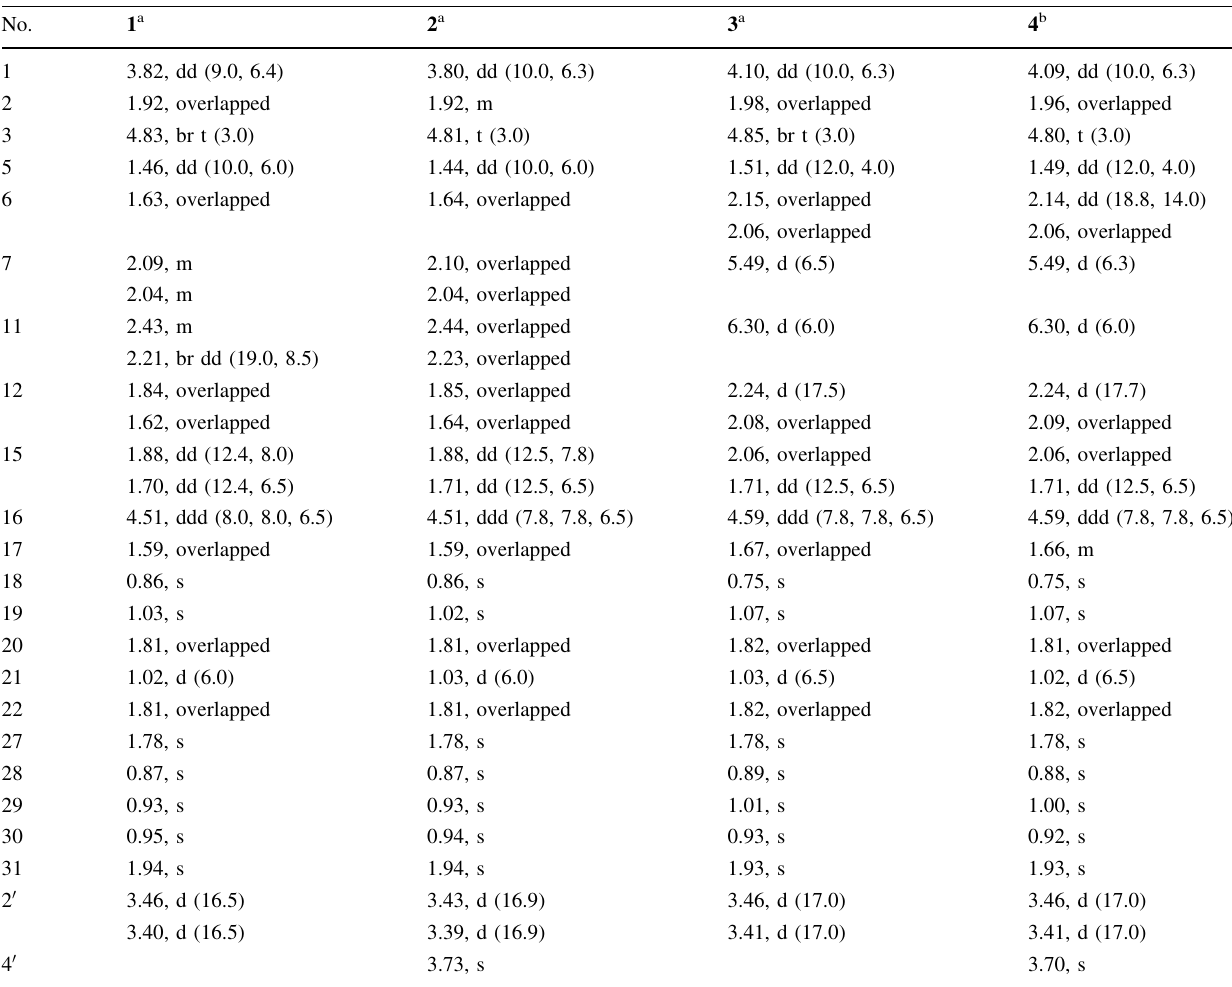
Table 1 1 H NMR spectroscopic data for compounds 1 – 4 (CDCl 3 )